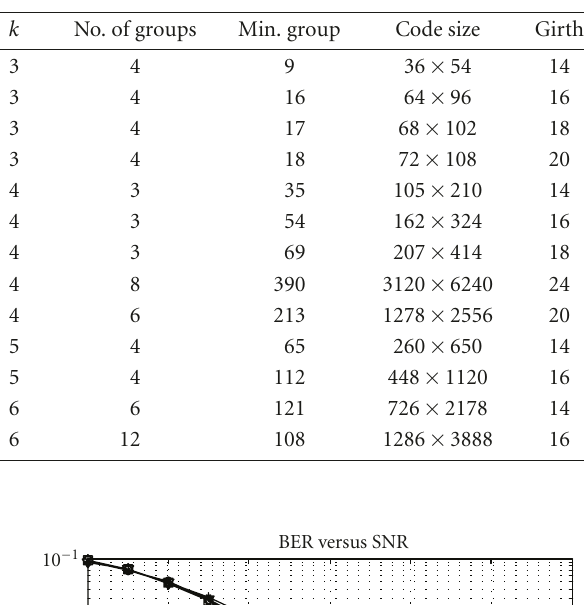
Figure 10: BER performance of larger codes compared to graphical codes with 35